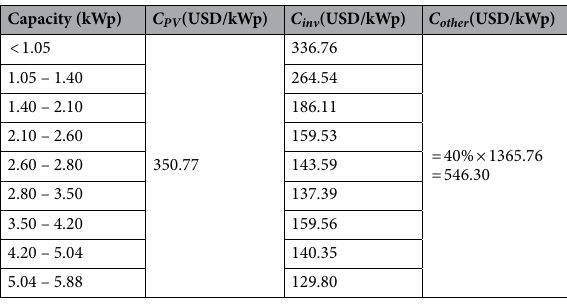
Table 4. CAPEX components price per capacity.